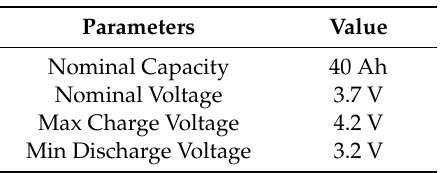
Table 1. Parameters of the experimental battery.